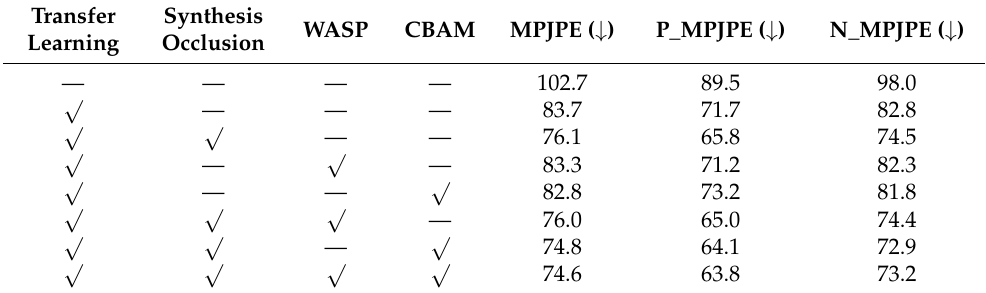
Table 4. Results of ablation